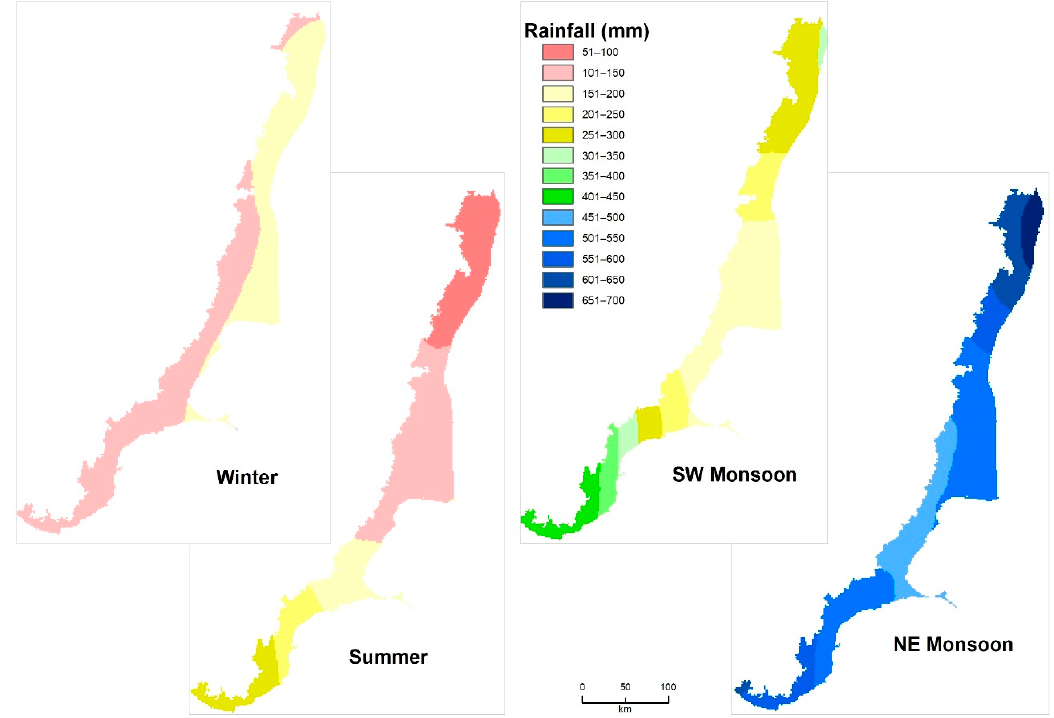
Figure 6. Average seasonal rainfall (1980-2017) in the coastal plains of Tamil Nadu.